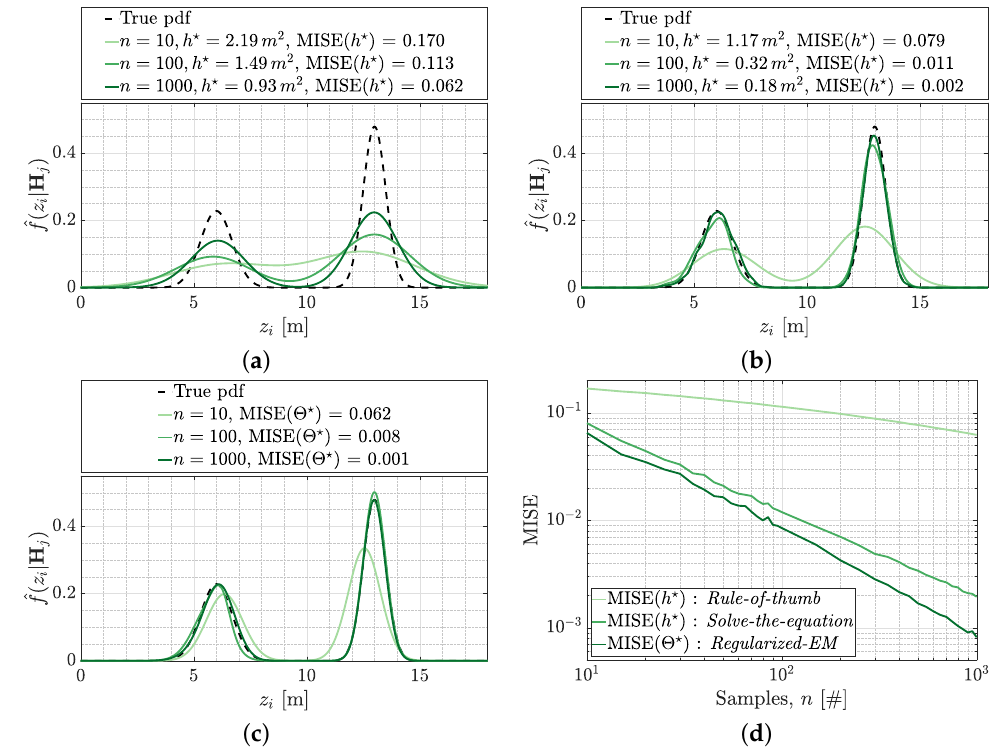
Figure 7. The mean integrated squared error of the estimated conditional range measurement likeli- hood function, ˆ f ( Z | H j ) , as determined using: ( a ) Kernel density estimation using optimal bandwidth, h (cid:63) , established from Rule-of-thumb [17]. ( b ) Kernel density estimation using optimal bandwidth, h (cid:63) , established from Solve-the-equation [18]. ( c ) Density estimation using optimal parameters, Θ , established from regularised expectation maximisation [19]. ( d ) The MISE for the three estimates are shown for increasing number of samples, n